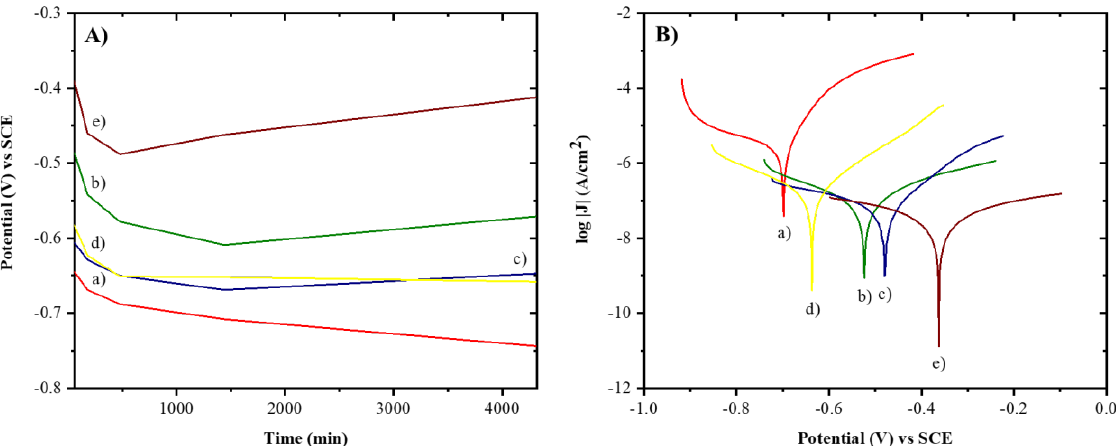
Figure 10. ( A ) OCP variation and ( B ) Tafel curves of: ( a ) uncoated 1018 steel (red), coatings of ( b ) PANI/AR (olive green), ( c ) SiO 2 -PANI/AR (blue), ( d ) CeO 2 -PANI/AR (yellow), and ( e ) TiO 2 A-PANI/AR (burgundy).